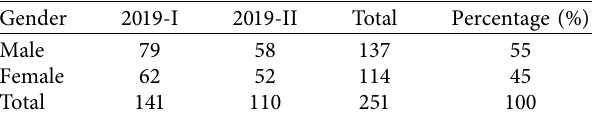
Table 3: Student gender.